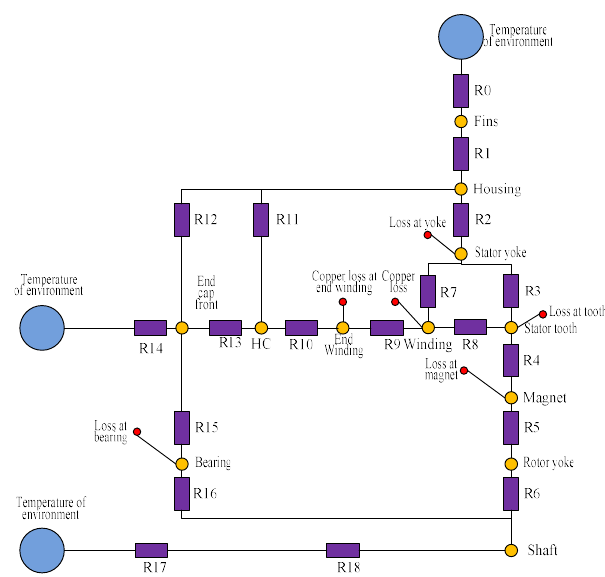
Figure 2. The model of the thermal network. Table 3. The description of thermal resistance.